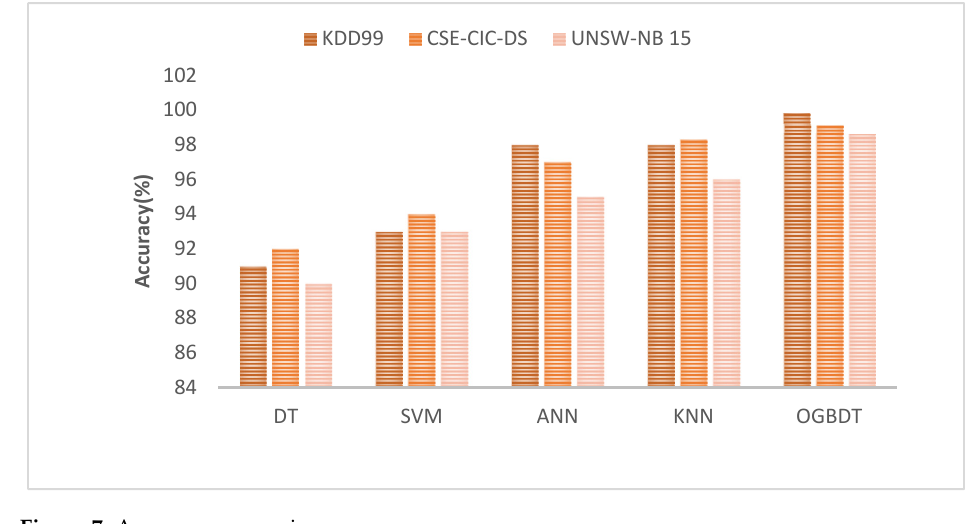
Figure 7. Accuracy comparison.